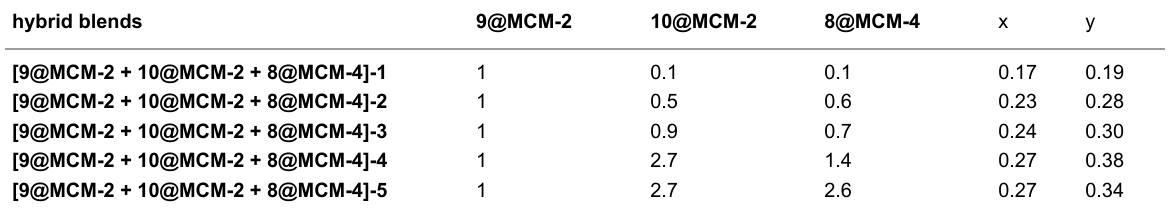
Table 2: Molar ratios of the hybrid blends [9@MCM-2 + 10@MCM-2 + 8@MCM-4] with their corresponding CIE coordinates x and y ( λ ex = 410 nm). hybrid blends